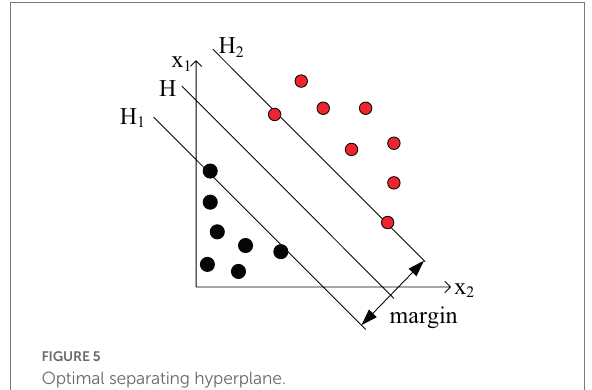
FIGURE 5 Optimal separating